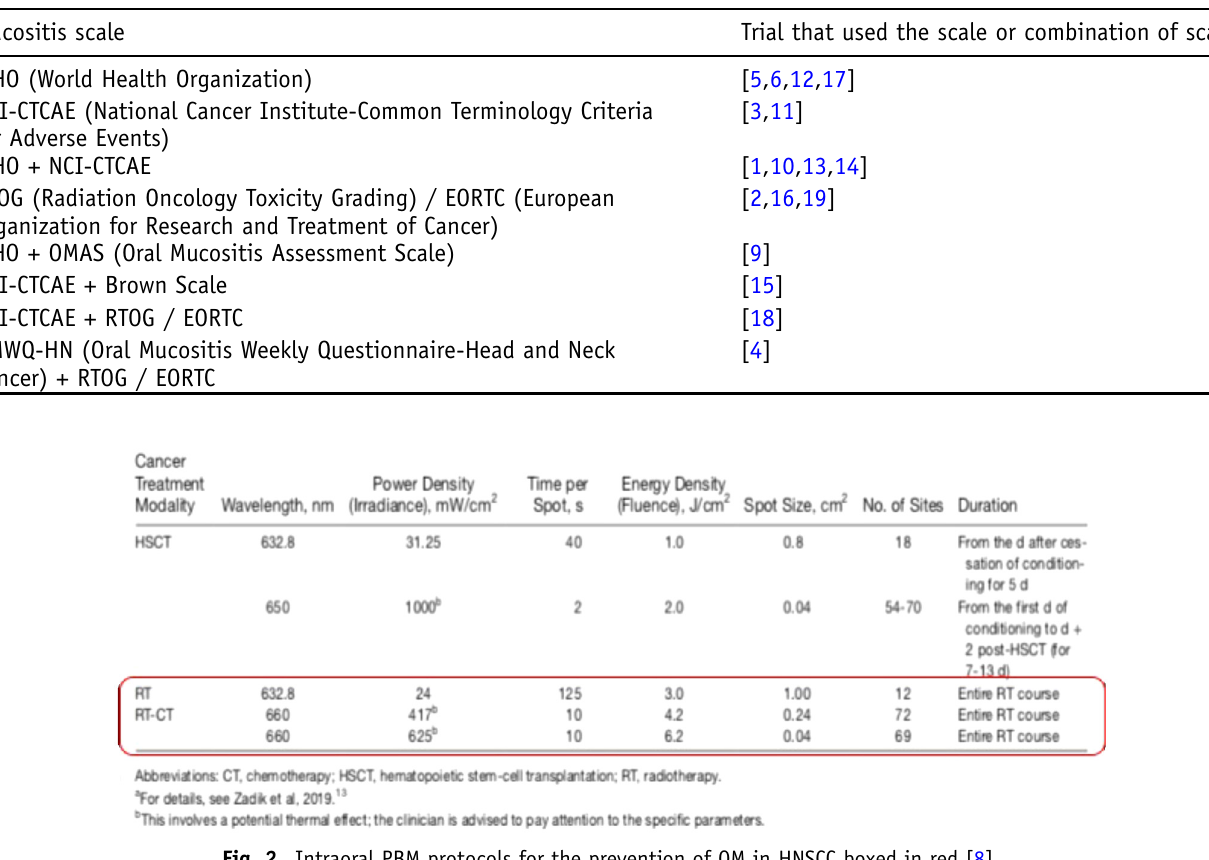
Table III. Summary of scales used to assess OM.